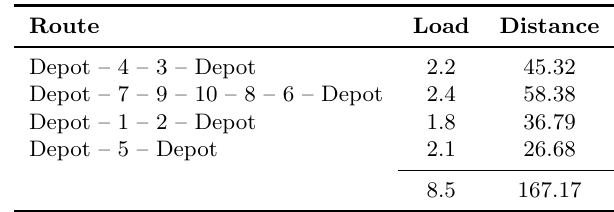
Table 5: The result from the application of the savings method for the illustrative example.